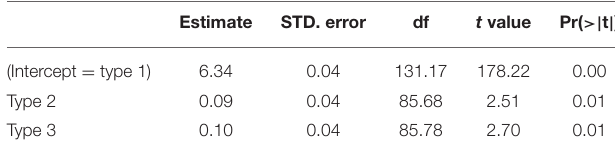
TABLE 6 | Linear regression analysis of the response latencies of the reaction times to correctly accepted words in experiment